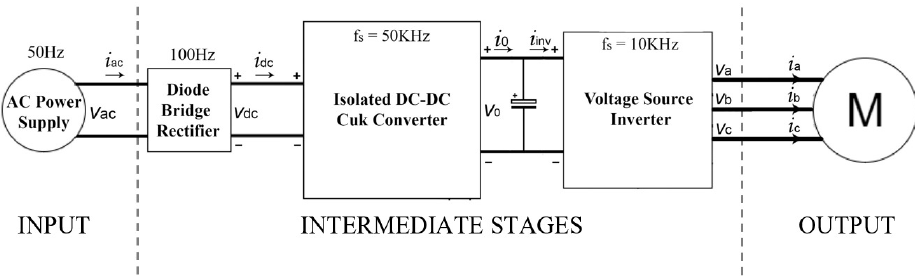
Figure 5. System diagram highlighting the various frequencies of operation in all the stages.